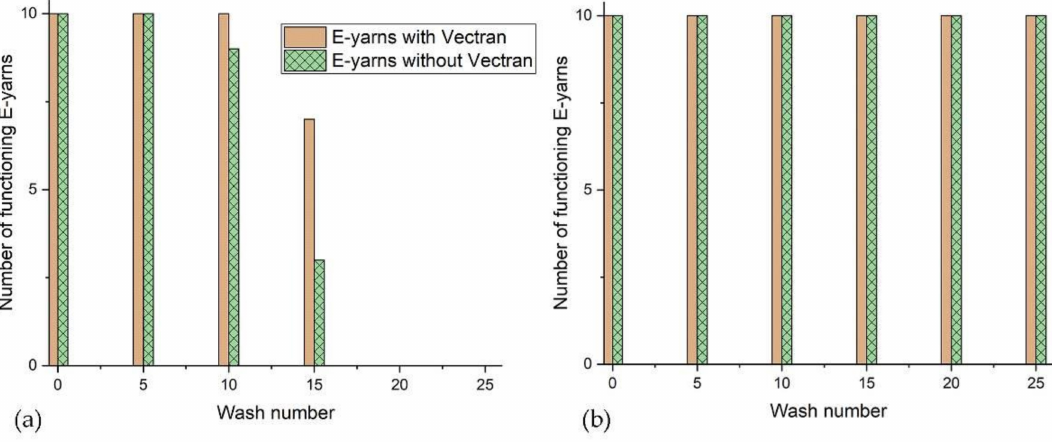
Figure 3. Results from wash tests for conductive wire E-yarns: ( a ) machine wash followed by tumble-drying; ( b ) machine wash followed by line drying, showing all E-yarns functioning after wash